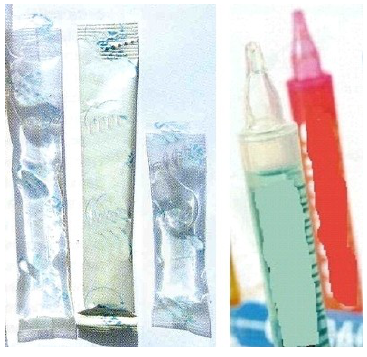
Figure 6. Examples of single-dose systems for oral liquid drugs